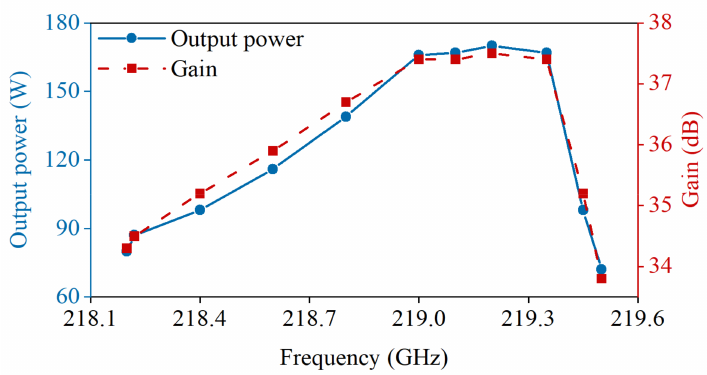
Figure 8. The output power and gain versus the